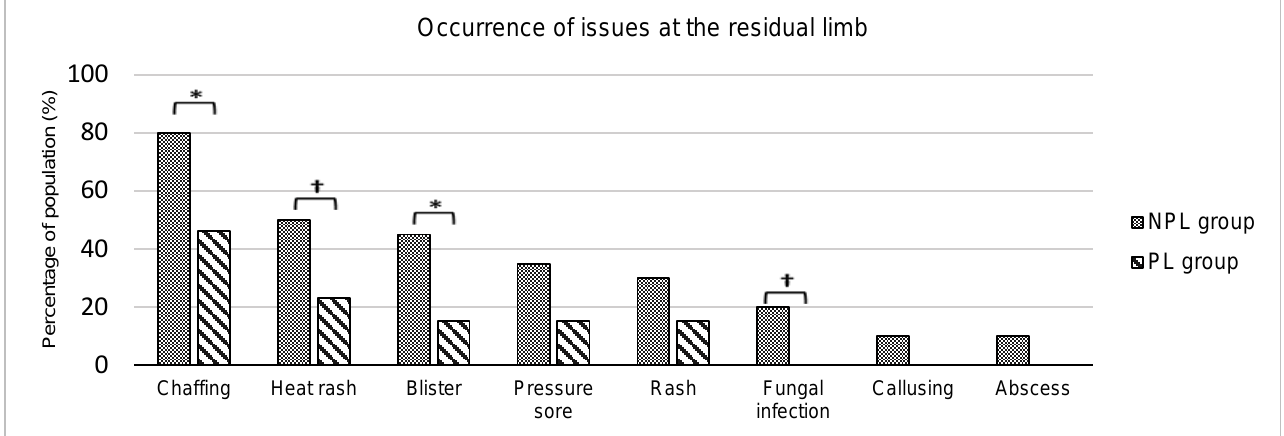
Figure 5: Percentage of the group populations that were affected by individual issues at the residual limb. The NPL group are indicated in grey and the PL group in green. Asterisks (*) indicate statistically significant results (p<0.05) while obelisks (†) indicate results that approached significance